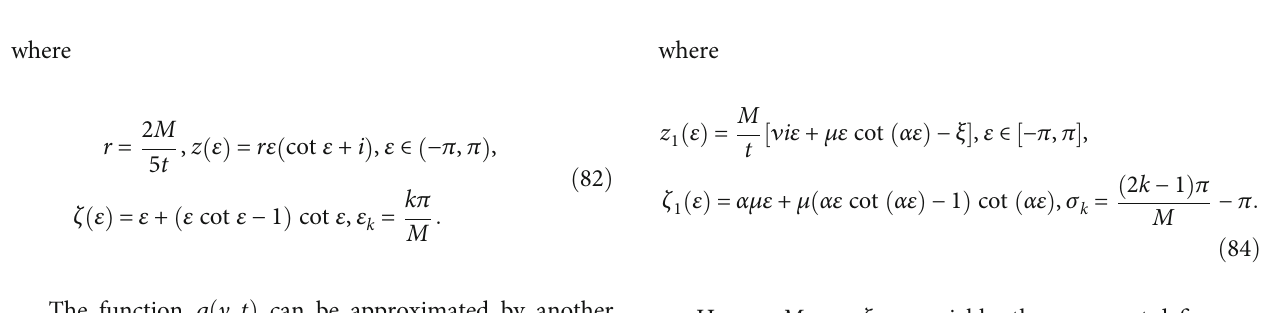
Figure 5: Temperature pro fi les T y